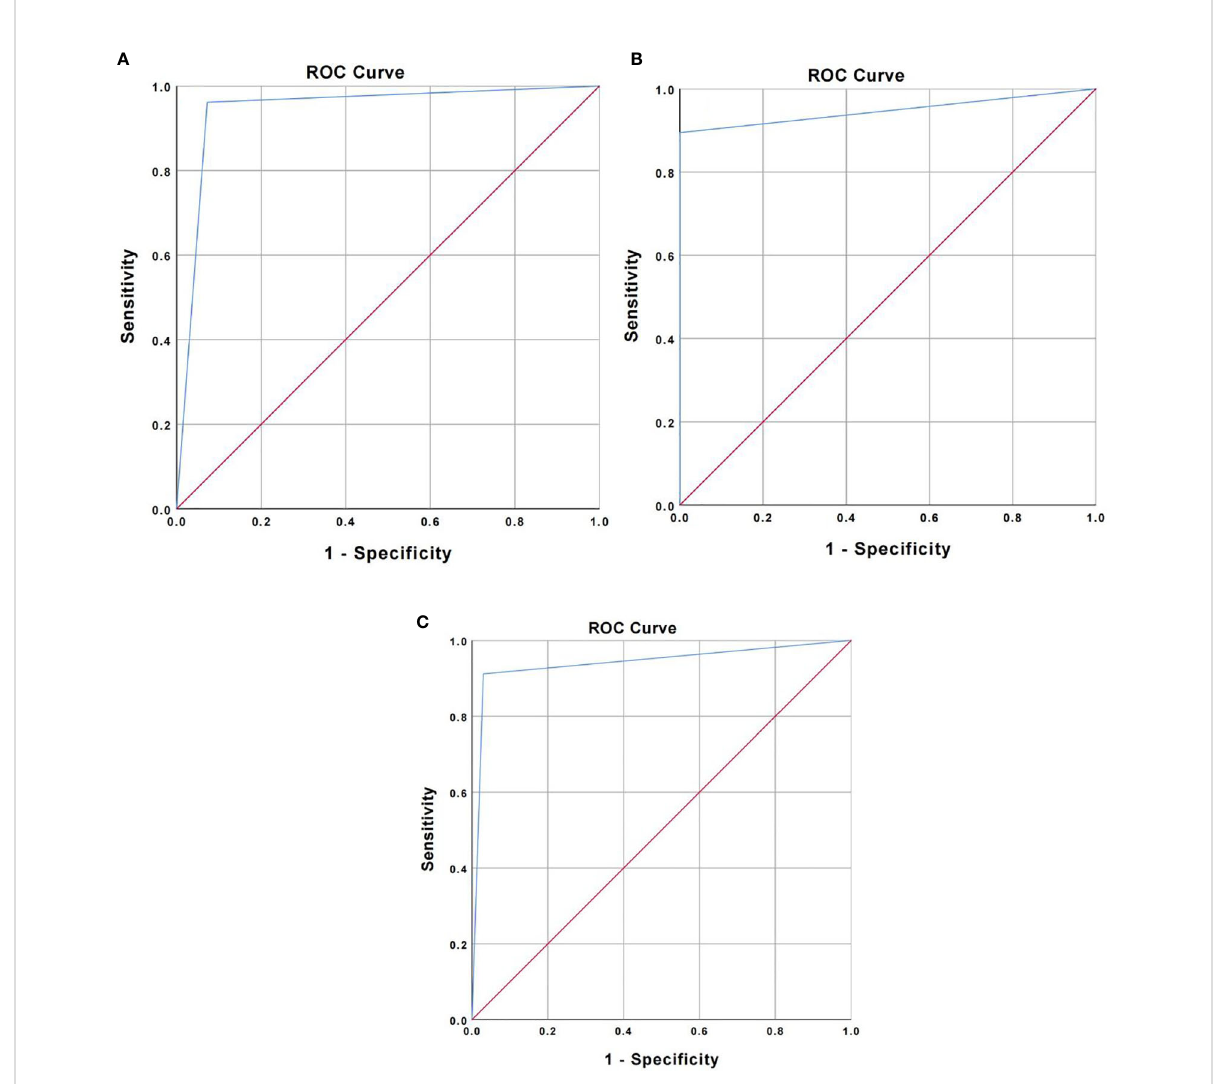
FIGURE 4 (A) ROC curve for verifying the accuracy of major OCT image features of squamous cell carcinoma. (B) ROC curve for verifying the accuracy of major OCT image features of adenocarcinoma. (C) ROC curve for verifying the accuracy of main OCT image features of small cell lung